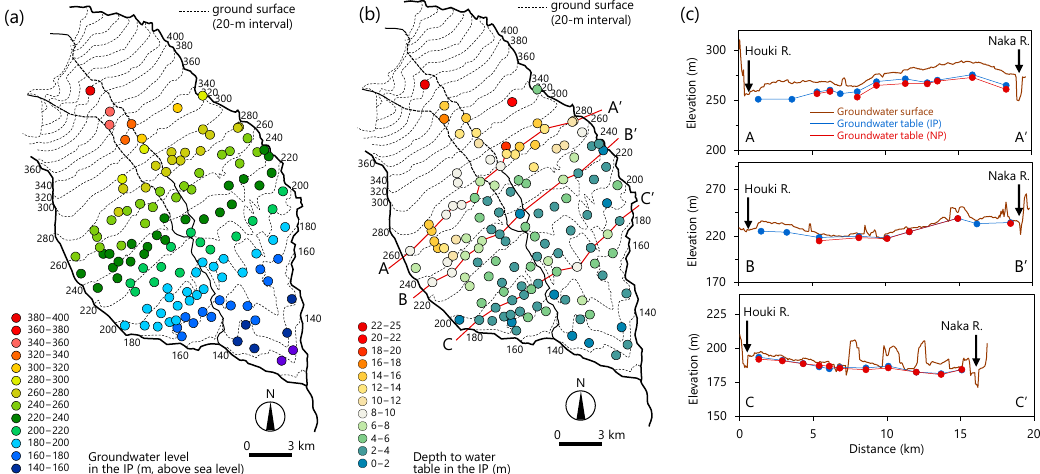
Figure 3. ( a ) Spatial distribution of the groundwater level in the irrigation period (IP), ( b ) depth to the water table in the IP, and ( c ) cross-sections of the groundwater table. The contour line of the ground surface was modified from the Geospatial Information Authority of Japan [30].